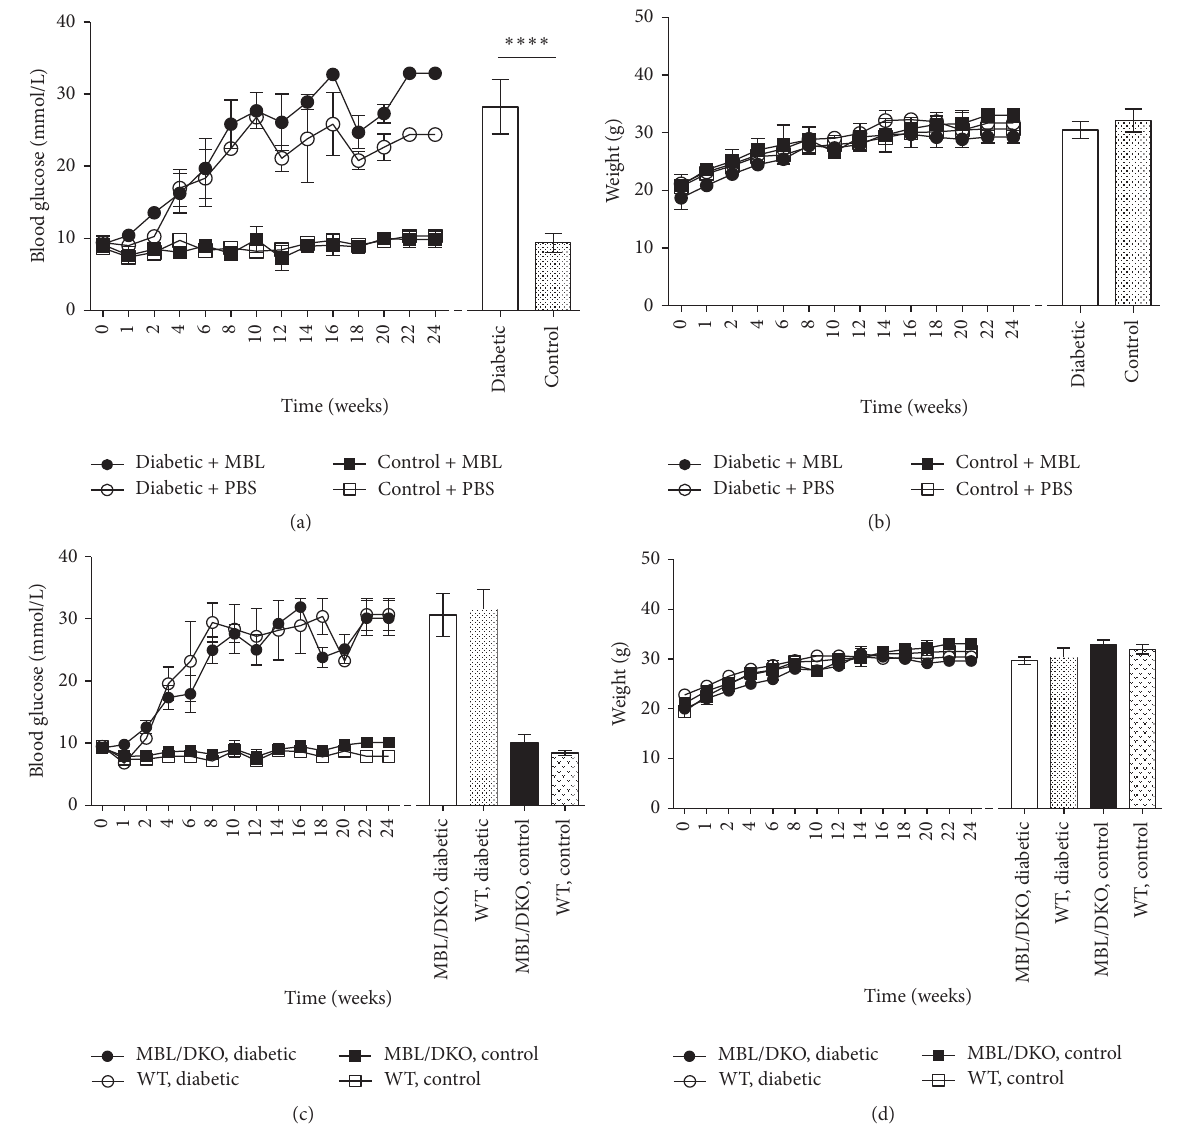
Figure 2: Blood glucose and weight gain of diabetic and nondiabetic control MBL/DKO and WT C57BL/6J mice. (a and b) Blood glucose and weight measurements for diabetic mice destined to be treated with rMBL AF680 ( 𝑛 = 6 ), diabetic mice destined to be treated with PBS ( 𝑛 = 6 ), control mice destined to be treated with rMBL AF680 ( 𝑛 = 6 ), and control mice destined to be treated with PBS ( 𝑛 = 6 ). (c and d). Comparison of the development of diabetes according to rising blood glucose levels and weight gain between diabetic ( 𝑛 = 6 ) and control ( 𝑛 = 6 ) C57BL/6J MBL/DKO mice and diabetic ( 𝑛 = 6 ) and control ( 𝑛 = 6 ) C57BL/6J WT mice. Statistical tests are given in the figure when significant, and comparisons are made between STZ treated and untreated groups at study end ( ∗∗∗∗ 𝑝 < 0.0001 ). Values are given in mean (dots) with SD